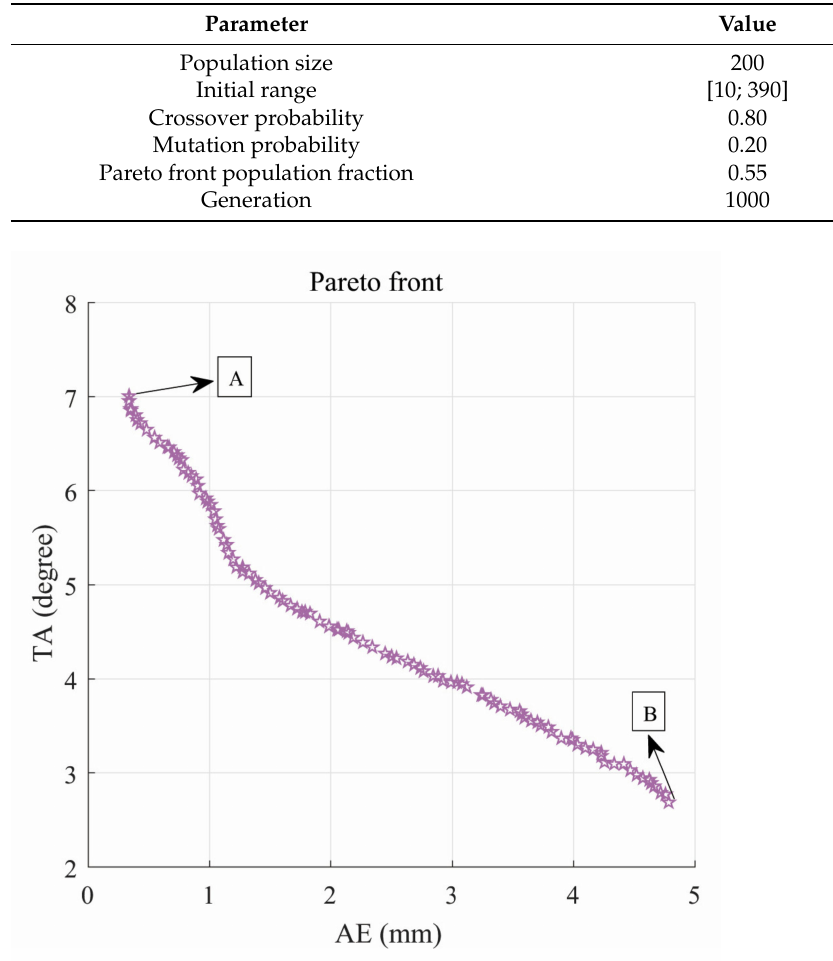
Table 3. Parameters of GA.